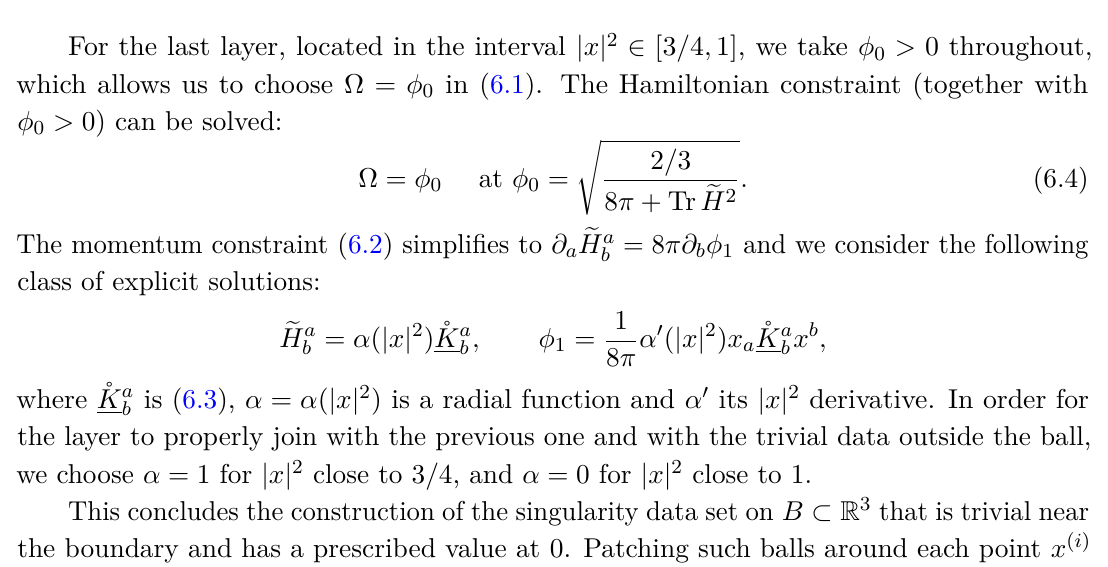
Figure 6 . Singularity data set constructed in lemma 6.1. It has prescribed values at x ( i ) and is trivial away from ball-shaped neighborhoods. Left: global structure. Right: some properties of the concentric layers around one x ( i )